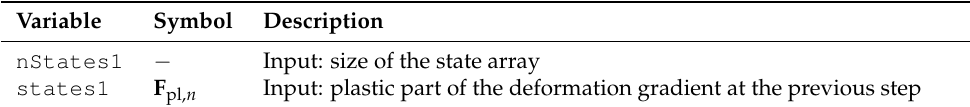
Table 4. List of state variables used in the algorithm for the elastic–ideal plastic material behavior in COMSOL Multiphysics ® .